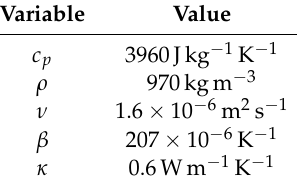
Table 1. Required thermo-physical properties of the liquid and their default values.